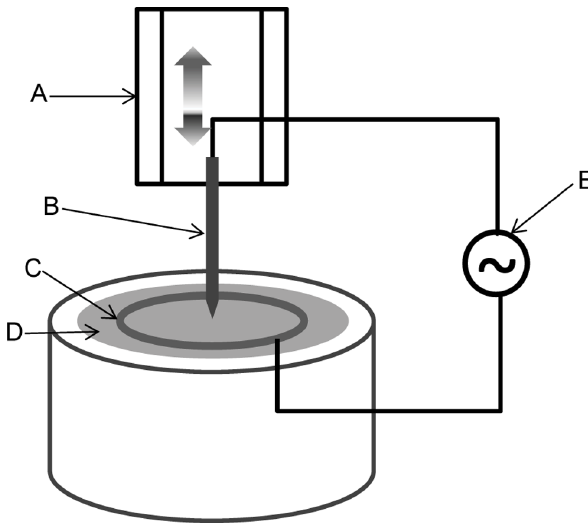
Figure 1. CNT fibril dielectrophoresis ‘‘pulling’’ stage assem- bled for this study. (A) A motorized linear stage moves only in the vertical direction, pulling the tungsten wire out of the solution. (B) A electrochemically sharpened tungsten tip functioned as a source electrode. (C) A submerged metal ring functioned as a counter electrode. (D) CNT dispersed solution. (E) High-frequency AC power source.